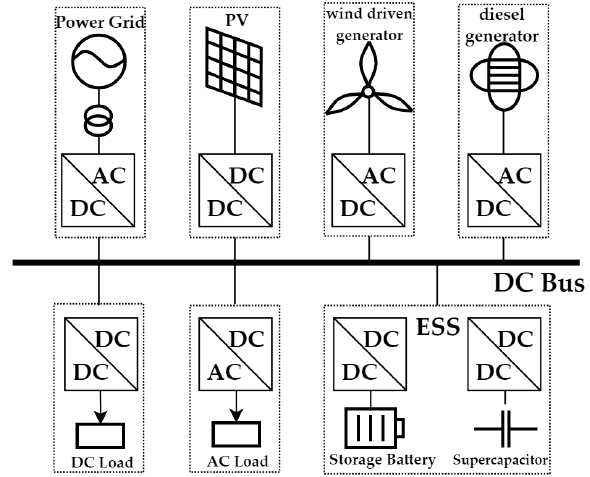
Figure 1. The typical structure diagram of a single bus DC microgrid. PV: Photovoltaic; DC: Direct